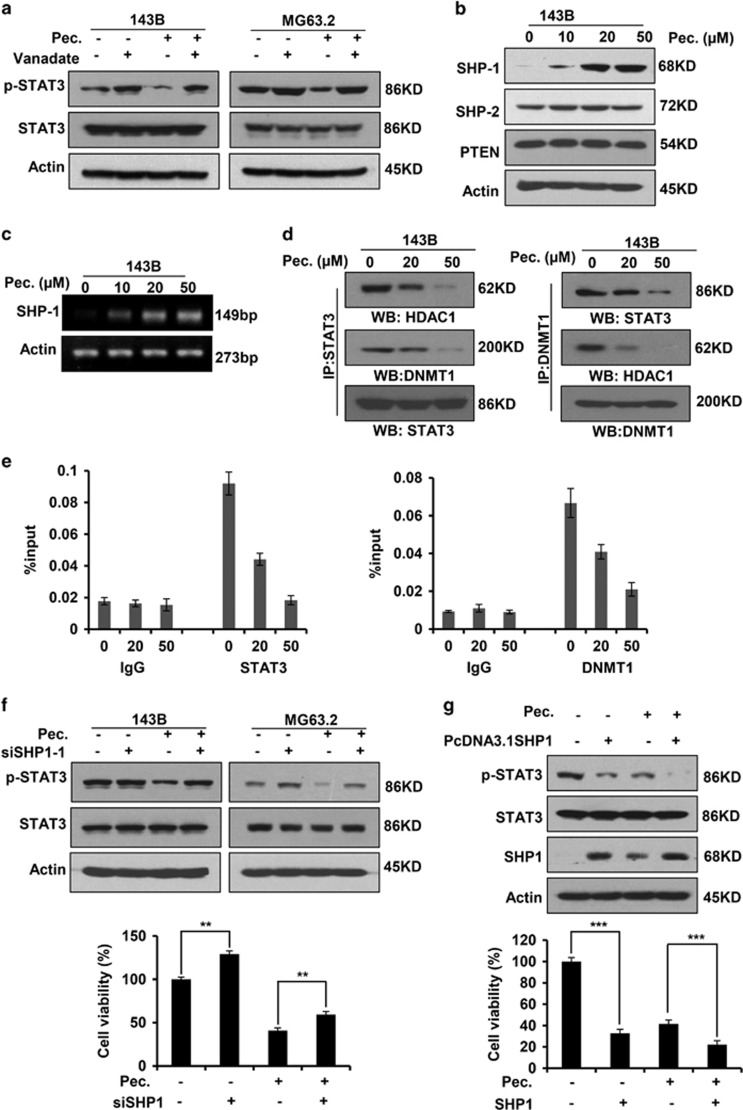
SHP-1 has an important role in pectolinarigenin-mediated STAT3 Tyr705 phosphrylation repression. (a) 143B and MG63.2 cells were treated with vanadate (100 μM) and pectolinarigenin (20 μM). Whole-cell lysates were prepared and applied to immunoblotting with an anti-phospho-STAT3 (Y705) antibody. (b) 143B cells were exposed to increasing concentrations of pectolinarigenin. SHP-1, SHP-2 and PTEN were probed by a western blot assay. (c) 143B cells were treated with pectolinarigenin for 24 h and then analyzed for SHP-1 mRNA expression by RT-PCR. (d) 143B cells were treated with pectolinarigenin and nuclear extracts were prepared. The immunoprecipitation assay was performed using indicated antibodies. (e) 143B cells were incubated with pectolinarigenin and the proteins were cross-linked with DNA and analyzed by a quantitative ChIP assay with indicated antibodies. (f) 143B cells were transfected with SHP-1 siRNA and treated with pectolinarigenin (20 μM). Western blot analysis was used for detecting phospho-Tyr705-STAT3 expression. Cell viability was measured by a MTS assay (**P<0.01). (g) SHP-1 was overexpressed in 143B cells. Cells were then incubated with 20 μM pectolinarigenin. Phospho-Tyr705-STAT3, STAT3 and SHP-1 were detected by a western blot assay. Cell viability was measured by a MTS assay (***P<0.001)